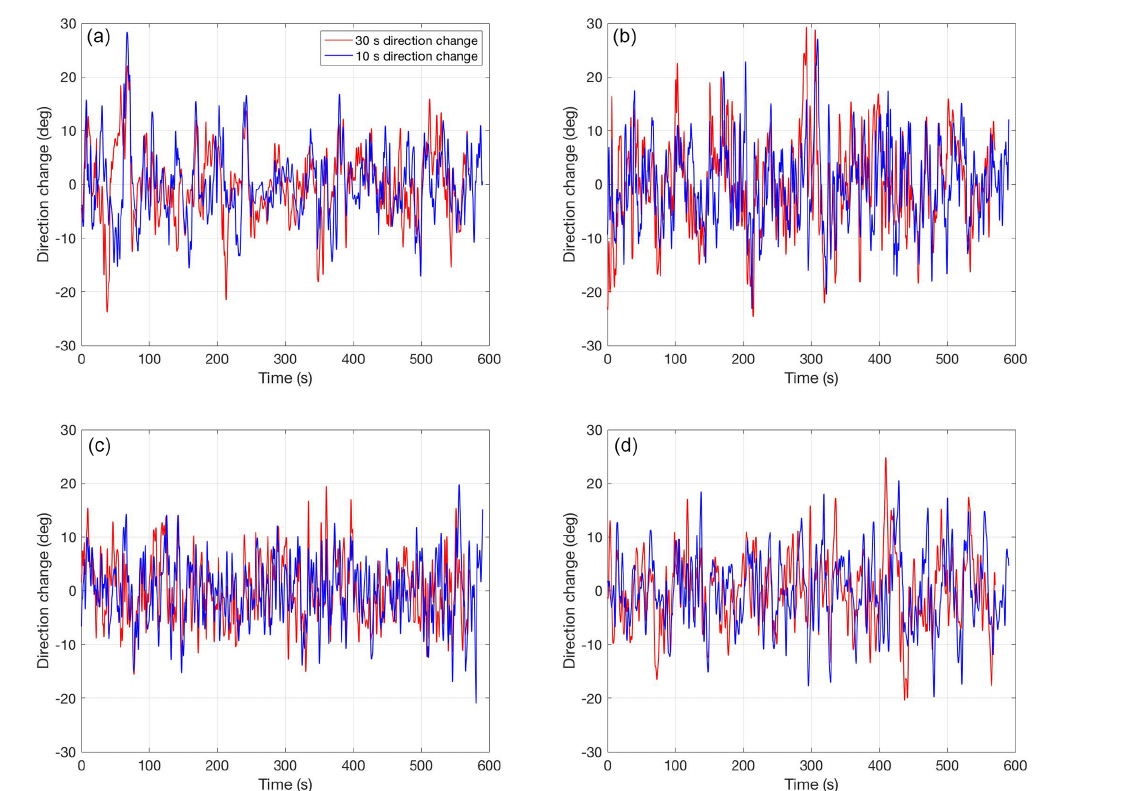
Figure 3. Time series of maximum wind direction change at various radii ( R ) of the hurricane at hub height: (a) inner edge of eyewall R = 10km, (b) within eyewall R = 12km, (c) outer edge of eyewall R = 15km, and (d) outside the eyewall R = 20km. The red and blue lines represent the maximum wind direction change over moving intervals of 30s (red) and 10s